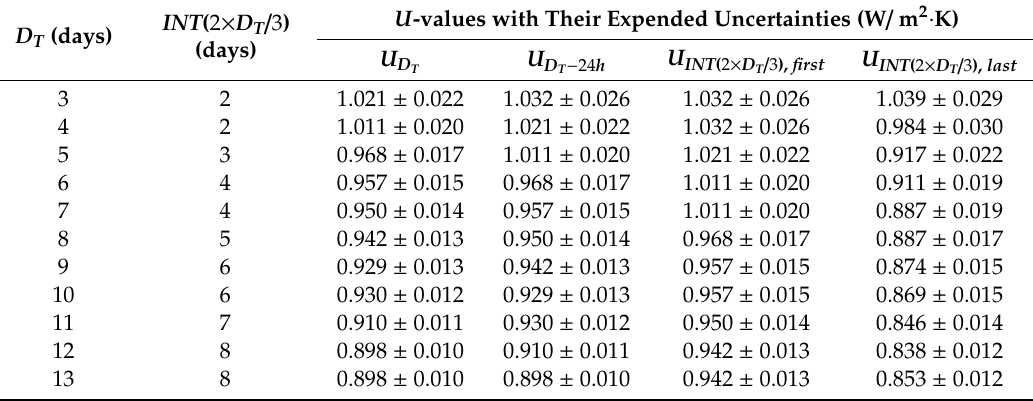
Table 5. U -values analyzed by average method and their expanded